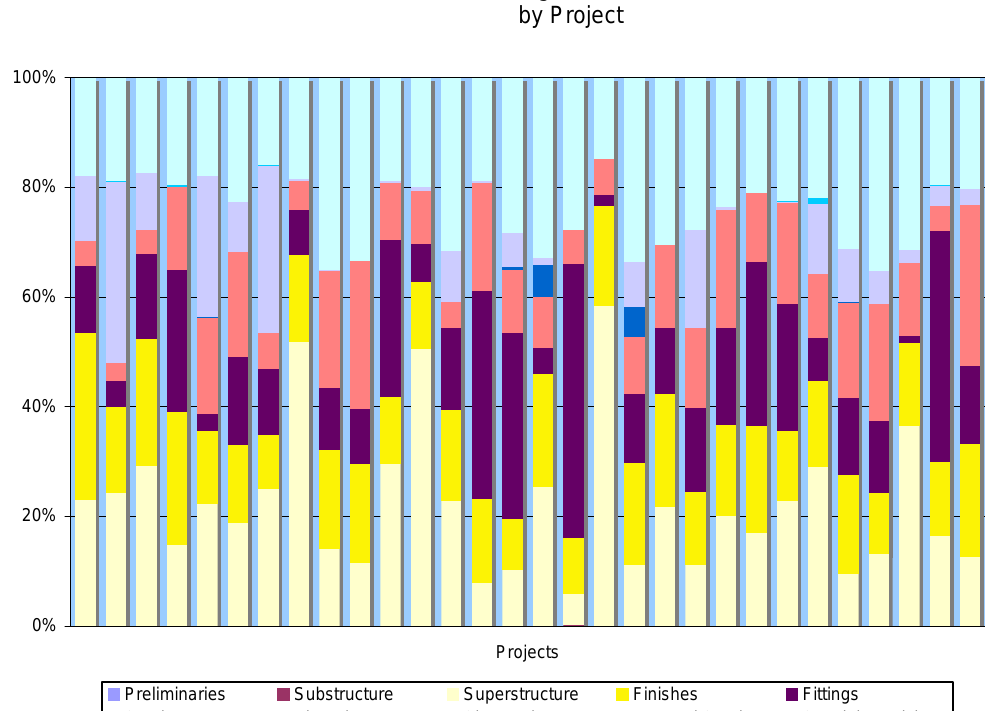
Figure 4: Distribution of Recurrent Embodied Energy by